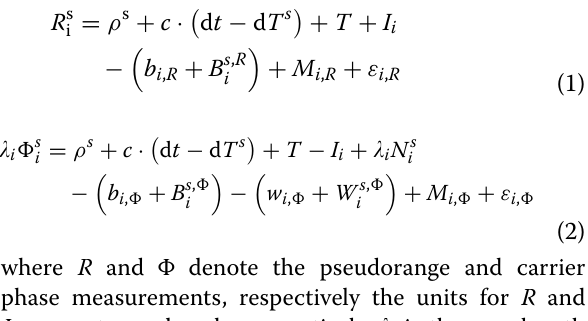
Fig. 1 a The moving station deployed beside the window in the MTR train and b the static station deployed beside the MTR train line. They were equipped with the same receiver type: the Trimble R10 receivers